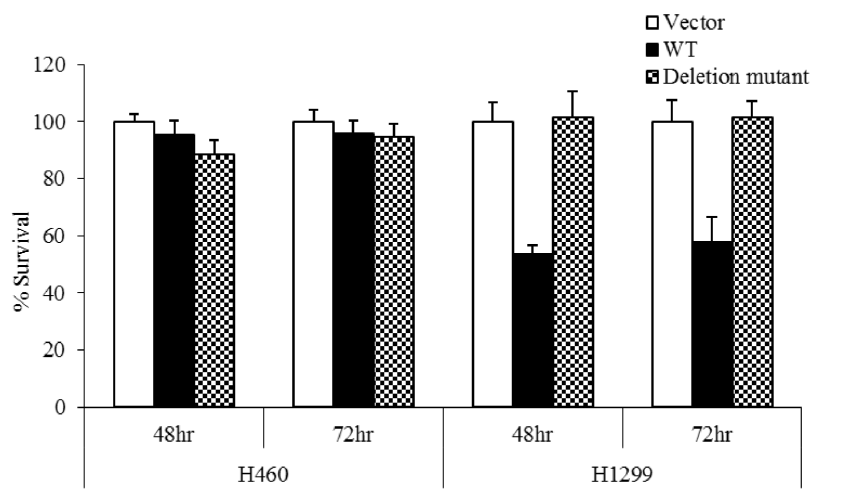
Figure 4. Deletion mutant fails to improve cell survival when expressed in conjunction with WT p53. 48 h or 72 h after transfection with WT p53, the survival rate for H1299 cells was 60%, whereas transfection with mutant p53 resulted in over 90% survival. In H460 cells, survival was over 90% regardless of p53 mutation status, showing definitively that the novel mutation did not improve cell survival unless present as the only available form of p53, and confirming its inability to act as a dominant negative mutation.